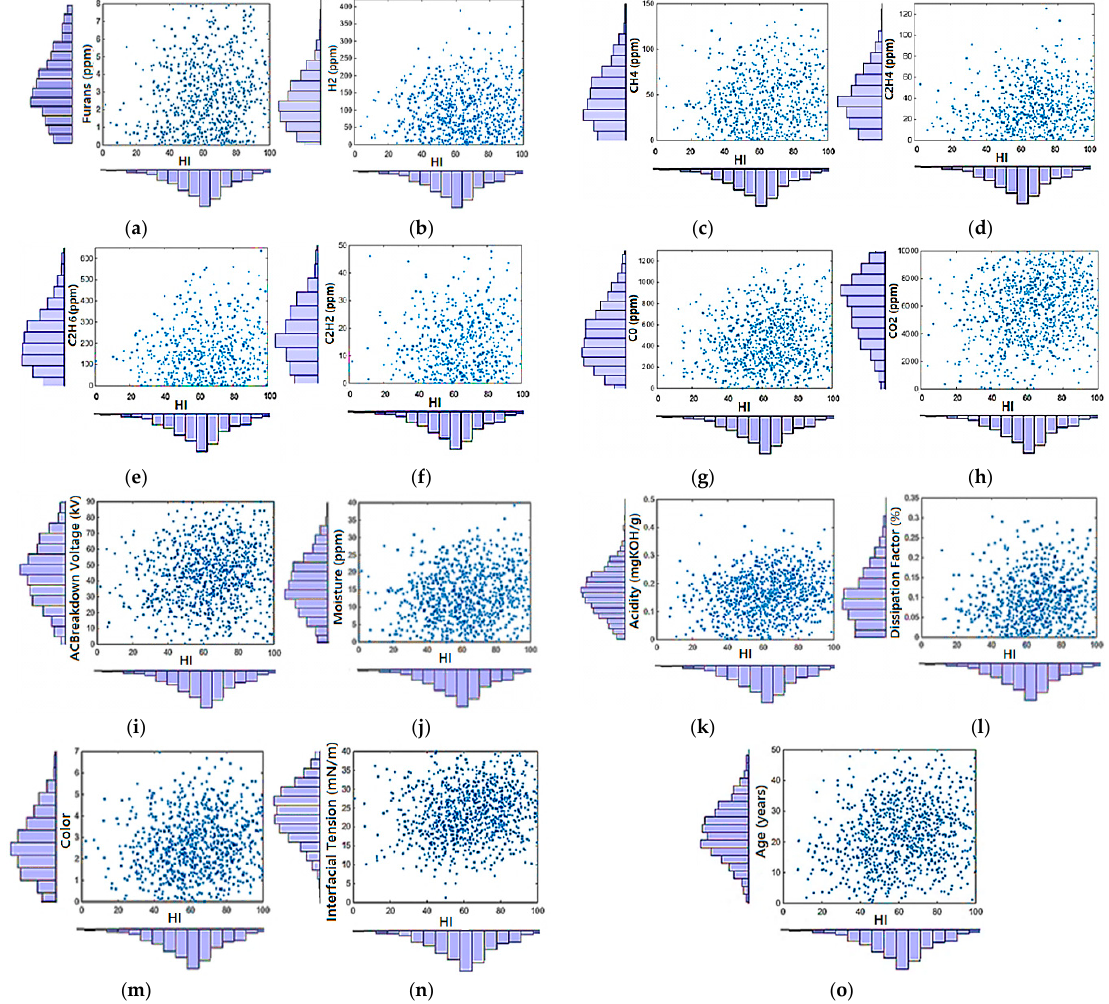
Figure 4. Simulated MCS data of ( a ) furans; ( b ) hydrogen (H 2 ); ( c ) methane (CH 4 ); ( d ) ethane (C 2 H 4 ); ( e ) ethylene (C 2 H 6 ); ( f ) acetylene (C 2 H 2 ); ( g ) carbon monoxide (CO); ( h ) carbon dioxide (CO 2) ; ( i ) ACBDV; ( j ) moisture; ( k ) acidity; ( l ) DF; ( m ) color; ( n ) IFT and ( o ) age versus HI.